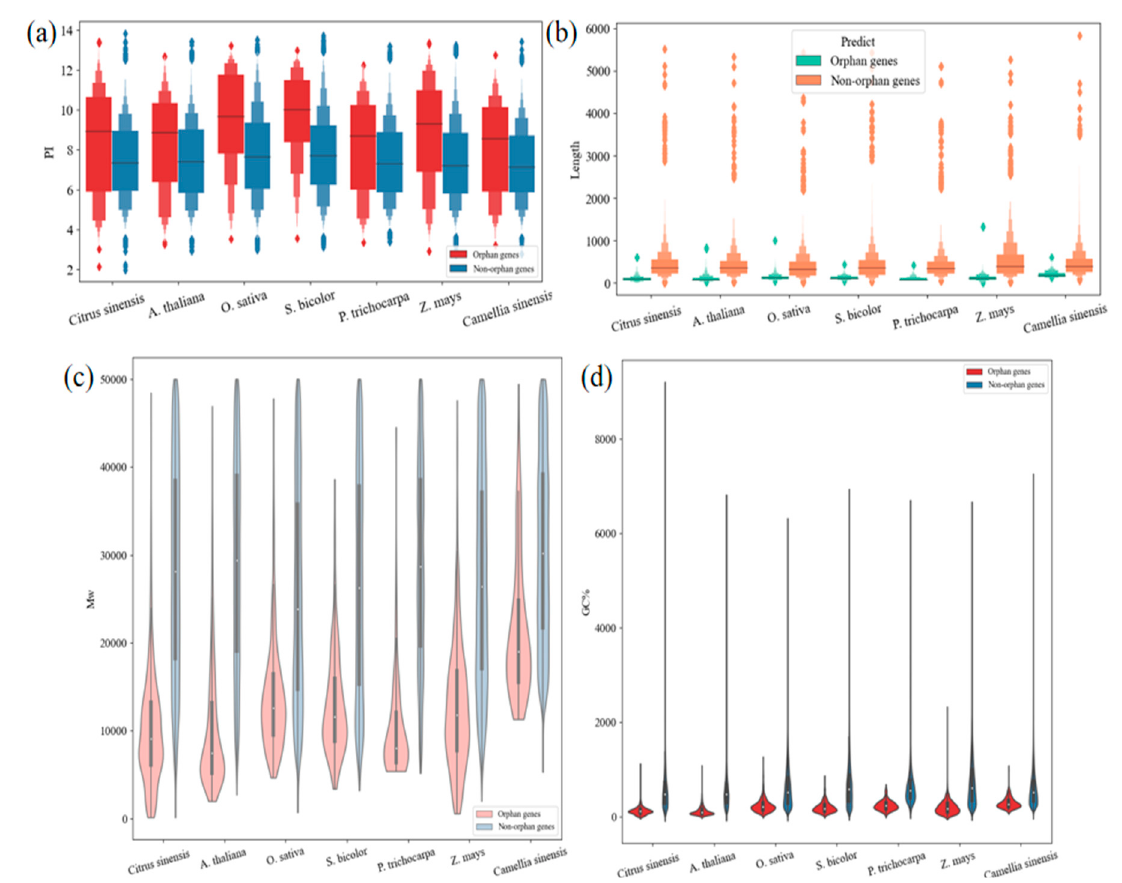
Figure 3. Comparison of various features of OGs and NOGs in seven species: ( a ) pI , ( b ) gene length, ( c ) Mw , ( d ) GC %. ( c ) Mw , ( d ) GC %.